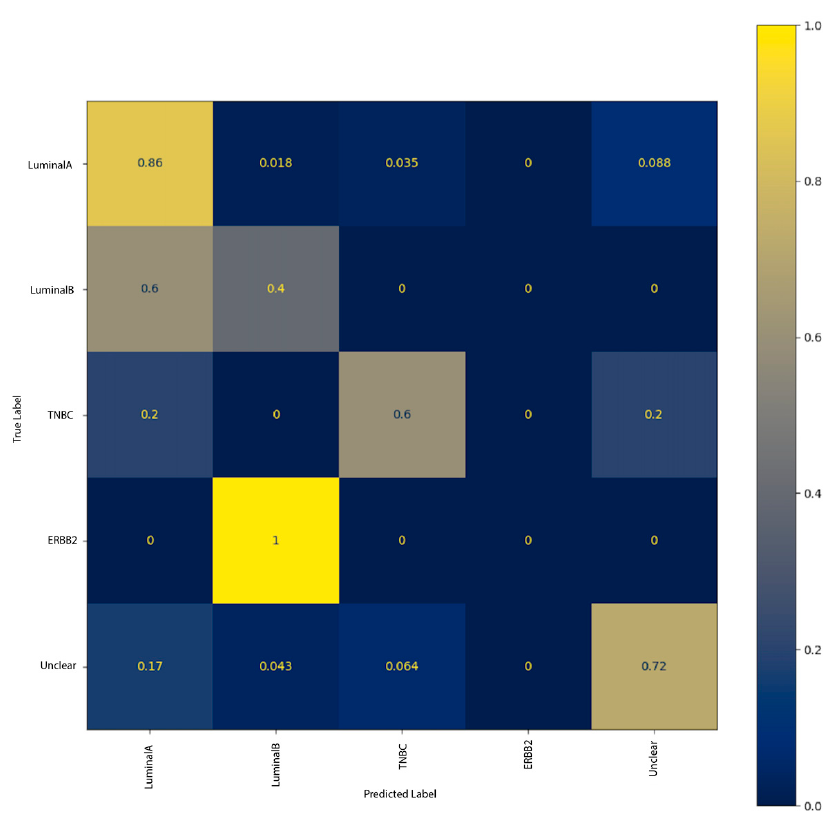
Figure 4. Normalized Confusion Matrix of XGBoost Model Predictions using the Hybrid set.